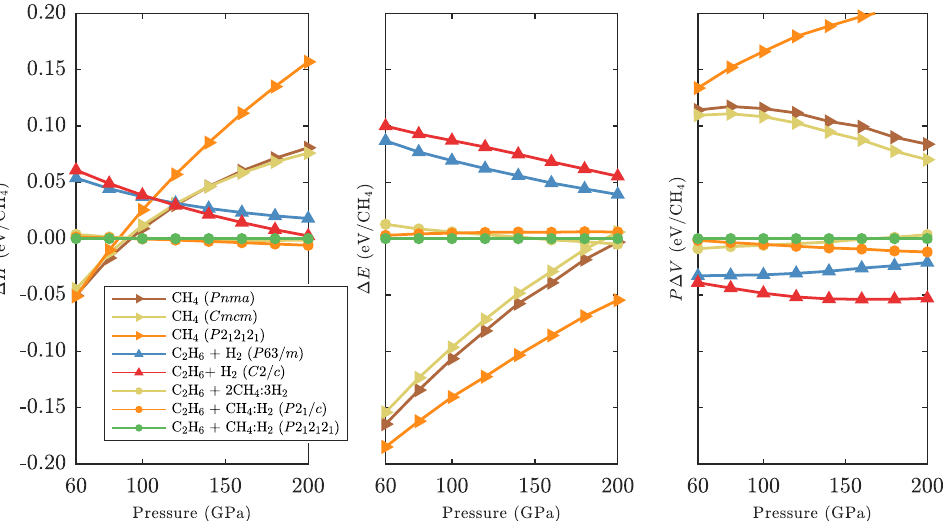
Figure 5. Relative formation enthalpies ∆ H ( left ), internal energies ∆ E ( middle ), and volume terms p ∆ V ( right ) for various hydrocarbons of global CH 4 stoichiometry in the pressure region 60–200